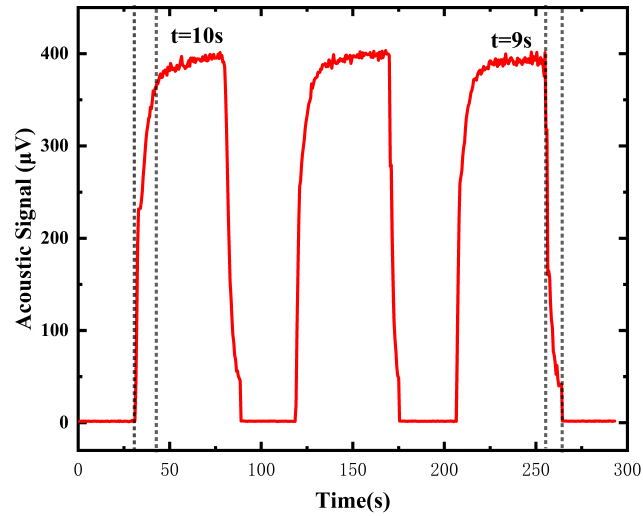
Figure 12. The response time characteristics of the